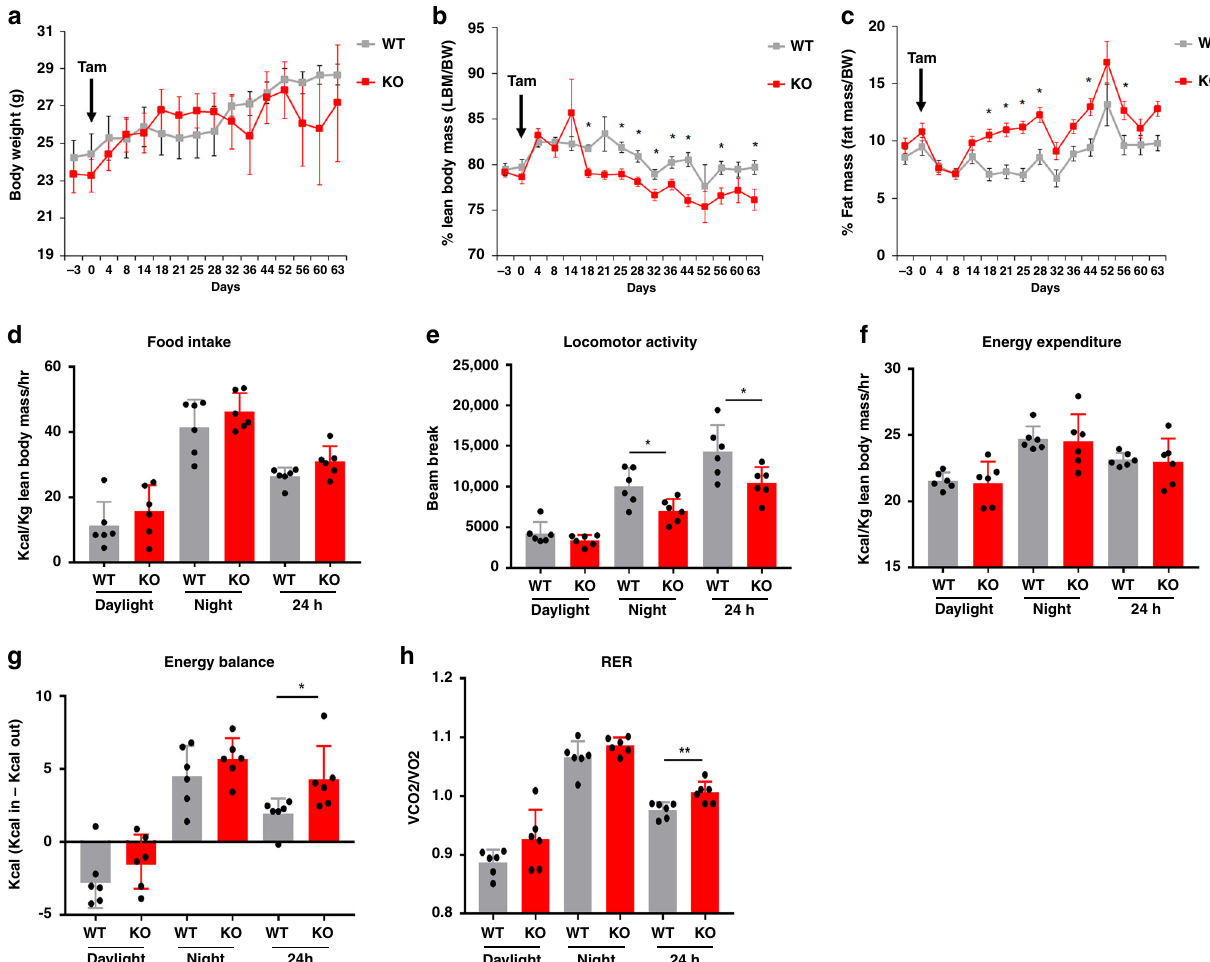
Fig. 2 Lkb1 deletion in the hepatocytes affects body composition and whole-body metabolism. a – c Changes in whole-body composition analyzed after tamoxifen injection in Lkb1KO livad (KO) mice. a Body weight (g) and of the percentage of total body weight accounted for by lean body mass ( b ) (g/bw) and fat mass ( c ) (g/bw), for KO ( n = 6) and control (WT, n = 6) mice over a period of 9 weeks. Data are expressed as means ± SEM. P values were determined by unpaired two-tailed t -test. * p ≤ 0.05. Tamoxifen was injected into the animals on day 0 (black arrow); calorimetric analysis was performed from day 14 to day 18. d Mean daylight-, night- and 24 h mean food intake (g/kg lean body mass/h). e Mean daylight-, night- and 24 h- mean spontaneous locomotor activity (beam break). f Mean daylight-, night- and 24 h mean energy expenditure (kcal/kg lean body weight/h). g Mean daylight-, night- and 24 h mean energy balance. h Mean daylight-, night- and 24 h mean respiratory exchange ratio (VCO 2 /VO 2 ) of KO and control mice. Means over 24 h were calculated from 96 h measurements. All graphical data ( d – h ) are expressed as the mean ± SEM of 6 animals per group. P values were determined